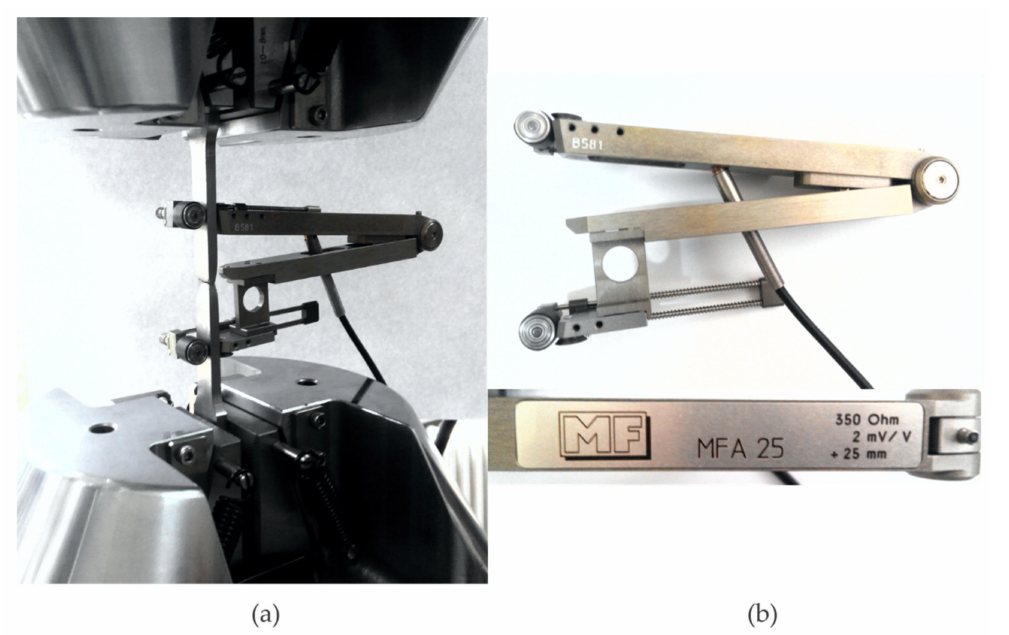
Figure 3. Testing equipment: ( a ) SHIMADZU servo-hydraulic machine, ( b ) MFA25 extensometer. As an outcome of the uniaxial tensile tests on the three flat specimens, for each steel, we determined the mechanical characteristics of the S355J2+N, S690QL, and X37CrMoV5-1 steel grades. The average yield strength, tensile strength, and Young’s modulus for each steel are shown in Table